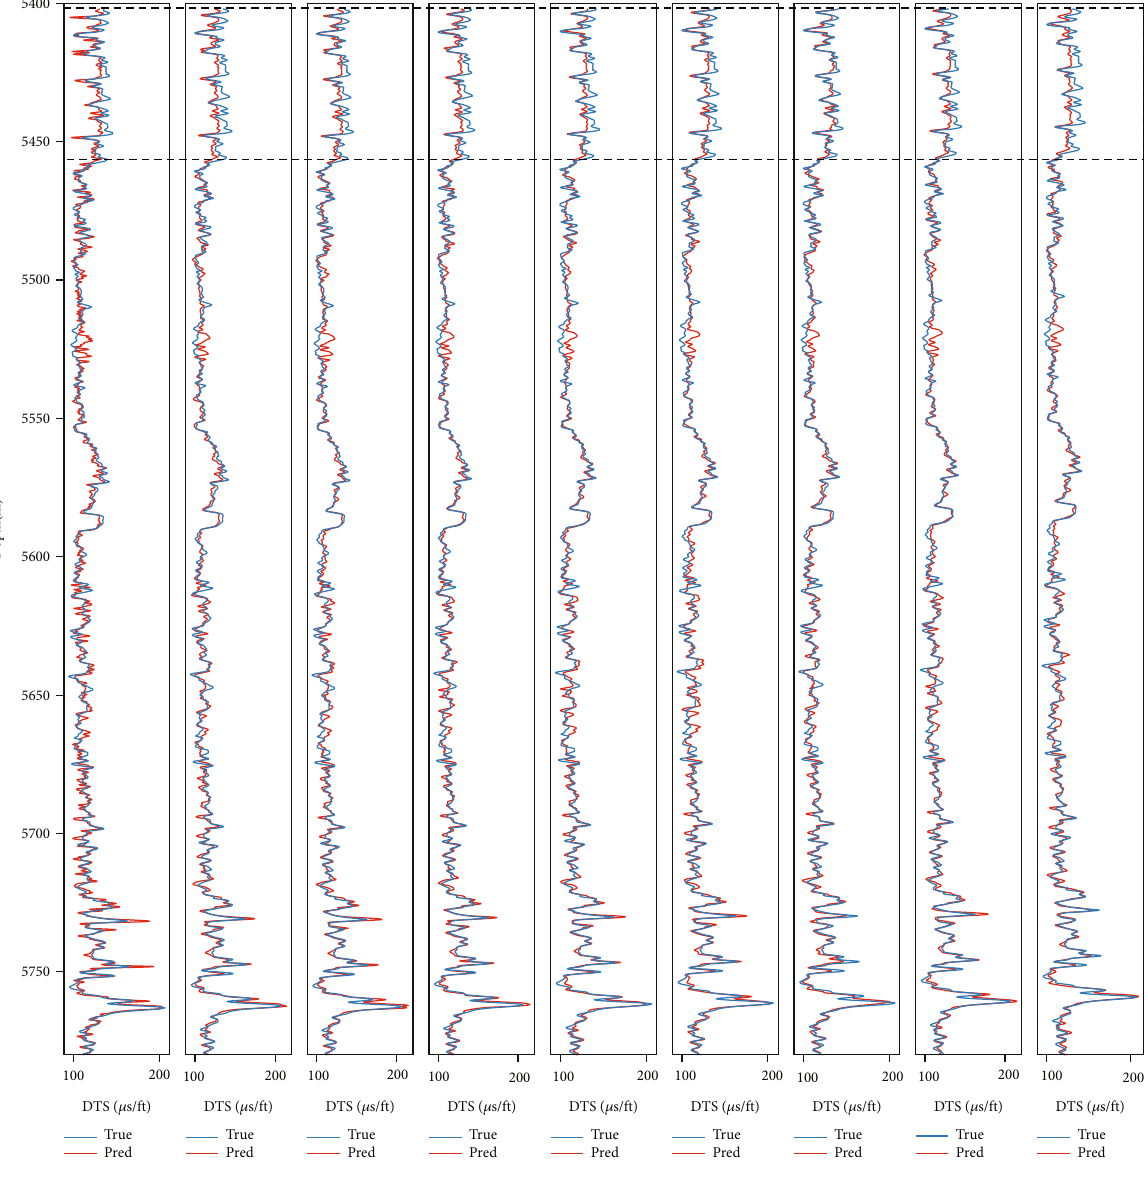
Figure 12: Nine experimental results based on the 2DCNN-GRU hybrid networks. The vertical lengths of the convolution kernels from left to right were set to 3, 10, 15, 20, 25, 30, 35, 40, and 65,